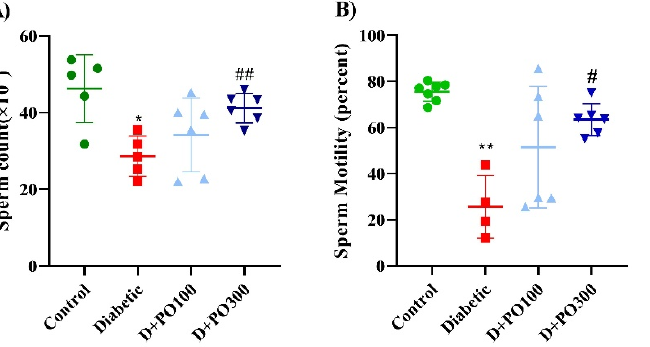
Figure 9. The effects of PO extract on ( A ) numbers and ( B ) motility of sperm in diabetic rats. The data are presented as mean ± SD. A one-way ANOVA test was carried out with the following Tukey–Kramer’s post hoc test; * p < 0.05, ** p < 0.01 vs. control group; # p < 0.05, ## p < 0.01 vs. diabetic group.